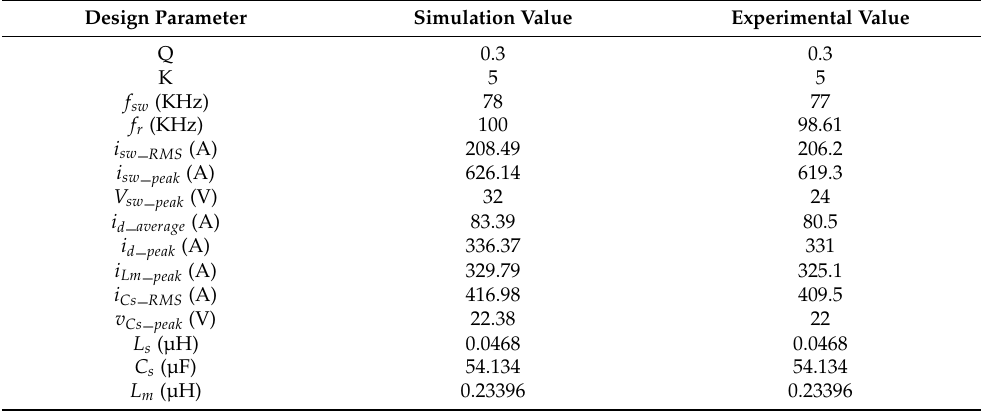
Table 6. Comparison of simulation and experiment